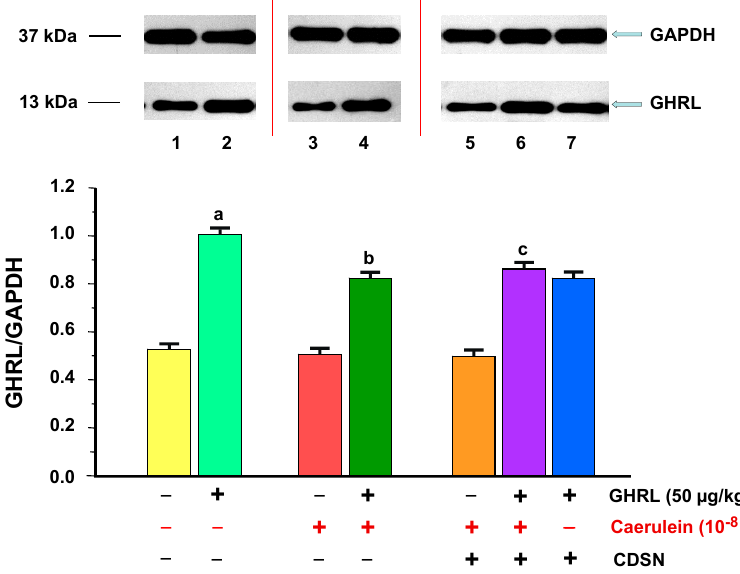
Figure 4. Analysis of ghrelin (GHRL) protein production determined by the methods of immunoblotting and immunoprecipitation, and densitometric analysis of GHRL/glyceraldehyde-3-phosphate dehydrogenase (GAPDH) protein ratio in pancreatic acinar cells: (line 1) acinar cells obtained from control sensory nerves (SN)-intact rats treated with saline, after isolation, acinar cells incubated in caerulein-free solution; (line 2) acinar cells obtained from SN-intact rats treated with GHRL, after isolation, acinar cells incubated in caerulein-free solution; (line 3) acinar cells obtained from SN-intact rats treated with saline, after isolation, acinar cells incubated in solution containing caerulein at a concentration of 10 − 8 M; (line 4) acinar cells obtained from SN-intact rats treated with GHRL, after isolation, acinar cells incubated in solution containing caerulein at a concentration of 10 − 8 M; (line 5) acinar cells obtained from rats with capsaicin deactivation of SN (CDSN) and treated with saline, after isolation, acinar cells incubated in solution containing caerulein at a concentration of 10 − 8 M; (line 6) acinar cells obtained from rats with CDSN and treated with GHRL, after isolation, acinar cells incubated in solution containing caerulein at a concentration of 10 − 8 M; (line 7) acinar cells obtained from rats with CDSN and treated with GHRL, after isolation, acinar cells incubated in caerulein-free solution. Reference protein: GAPDH. a p < 0.05 compared to control acinar cells obtained from rats with intact SN and treated with saline (line 1); b p < 0.05 compared to acinar cells stimulated with caerulein after isolation from SN-intact rats treated with saline (line 3); c p < 0.05 compared to acinar cells stimulated with caerulein after isolation from rats with CDSN and treated with saline (line 5). In each experimental group, the number of observations was at least 6.